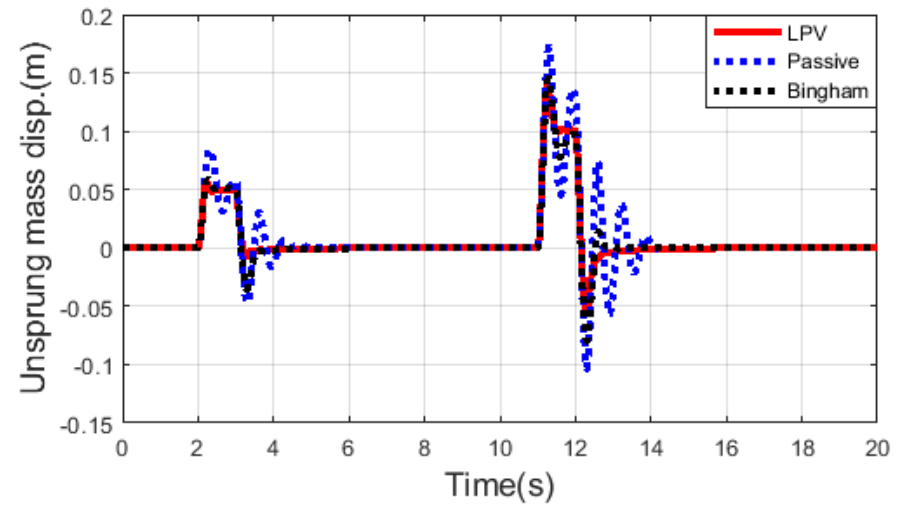
Figure 5. Unsprung mass displacement.